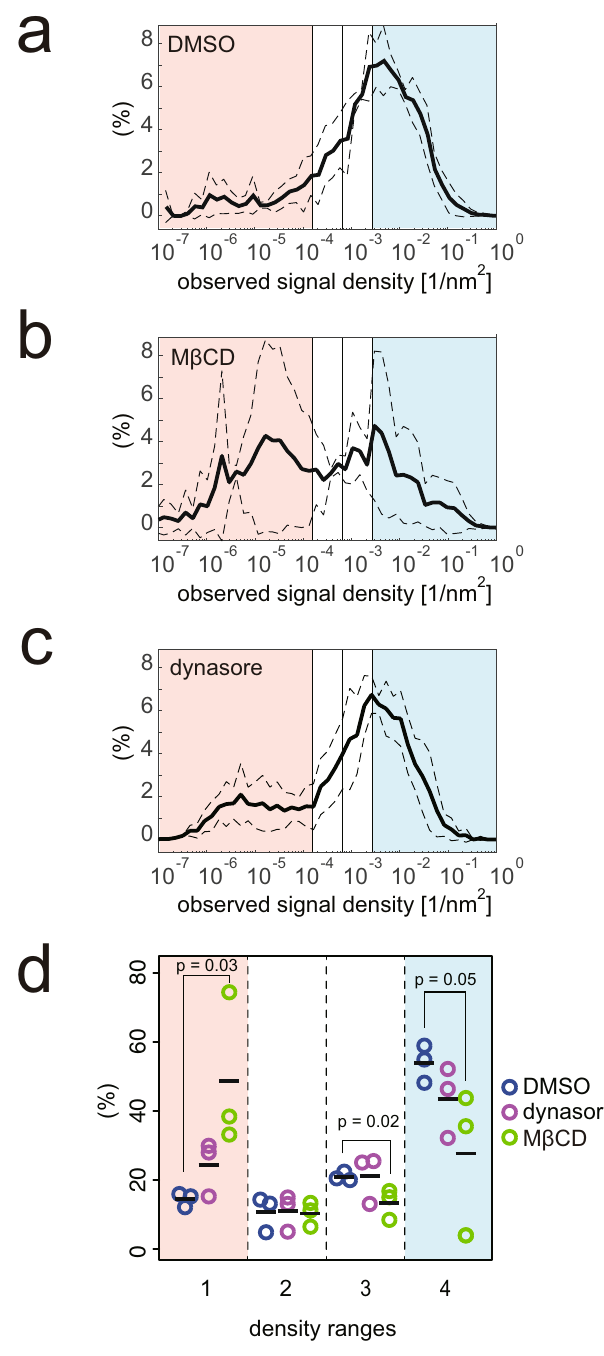
Figure 5. Local density estimation from STORM signals of caveolin-1 upon M β CD or dynasore treatment. ( a – c ) The average density distributions of the STORM signals by the 4 th NND of caveolin-1 under ( a ) control DMSO treatment, ( b ) 10-mM M β CD treatment for 10 min, and ( c ) 80- μ M dynasore treatment in isotonic medium for 10 min, as analysed in Fig. 3. ( d ) Percentages of caveolin-1 by the density ranges in each cell as in Fig. 3f. The average percentages at the dispersed caveolin-1 range between cells treated with DMSO and M β CD were significantly different. Indicated p-values were obtained using the Student’s